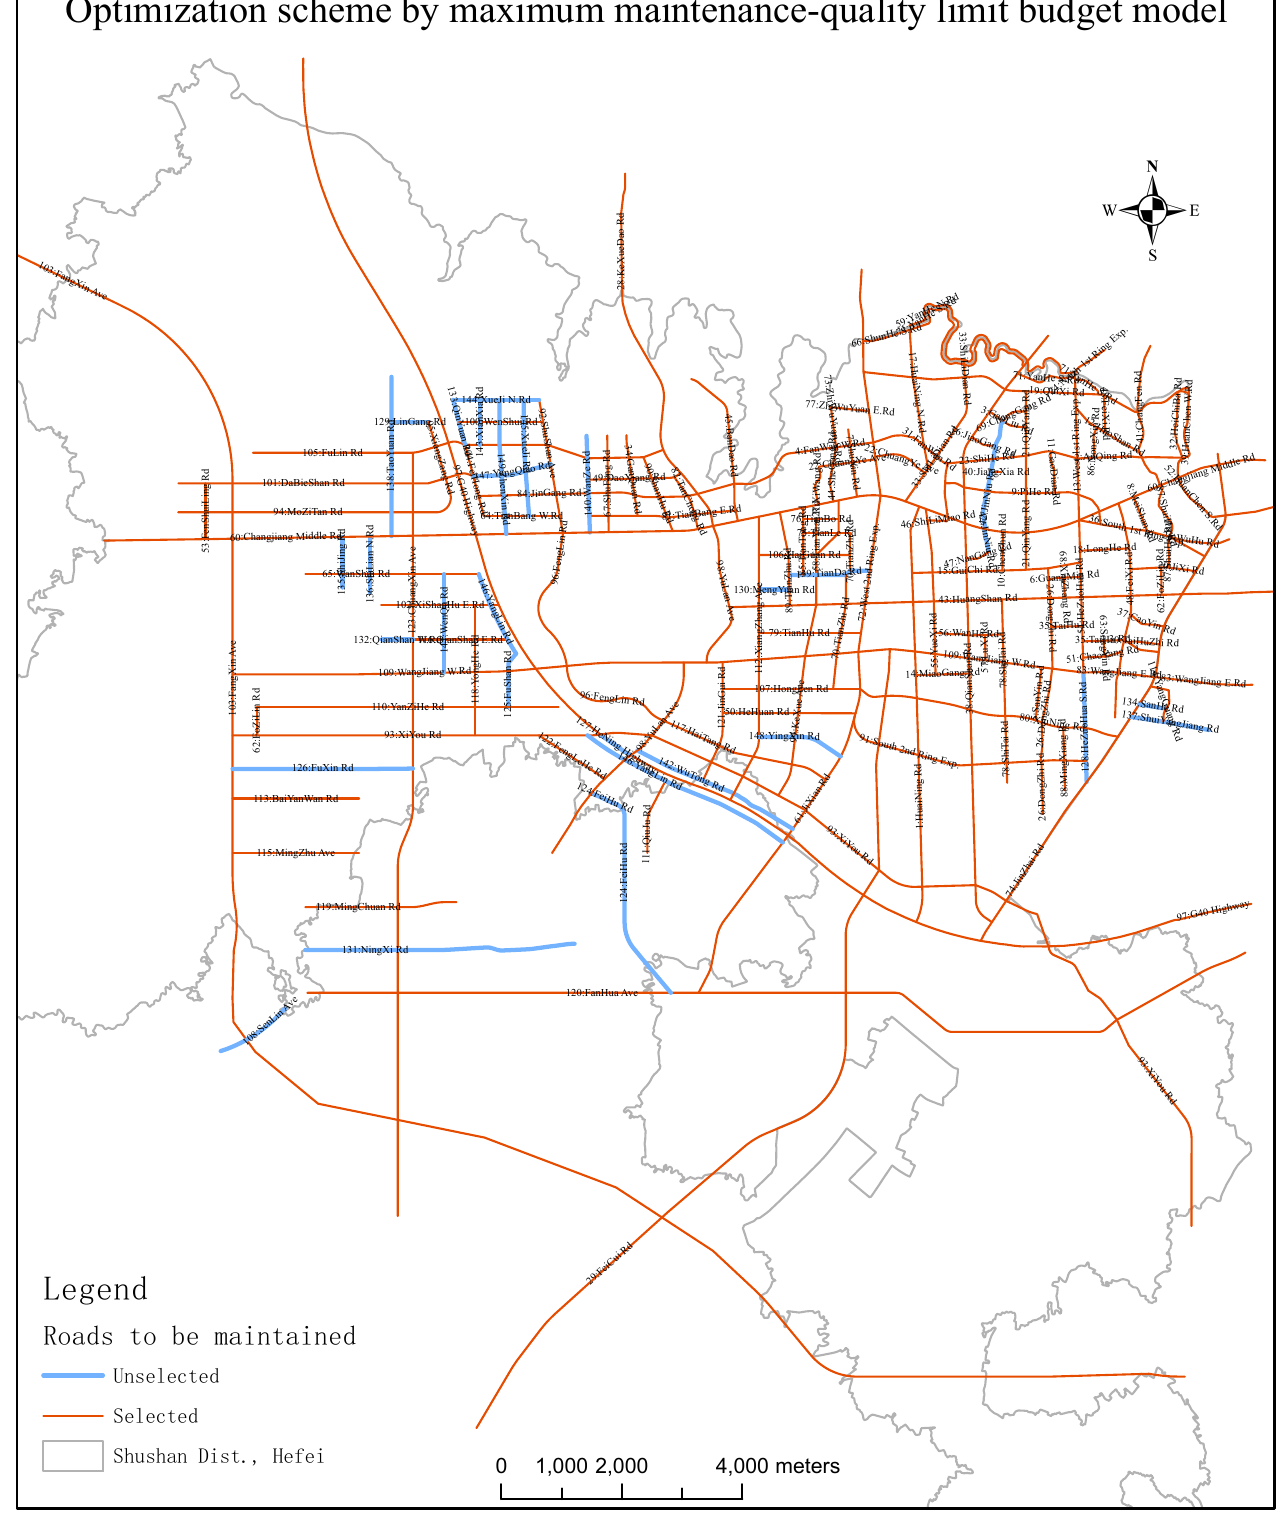
Figure 2. Pavement maintenance scheme obtained using the MMQLB